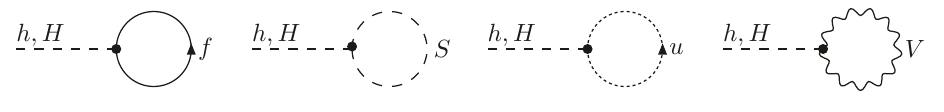
Figure 1 . Tadpole diagrams for the light Higgs boson h and the heavy Higgs boson H, where f; S; u; V stand for generic fermion, scalar, ghost, and gauge